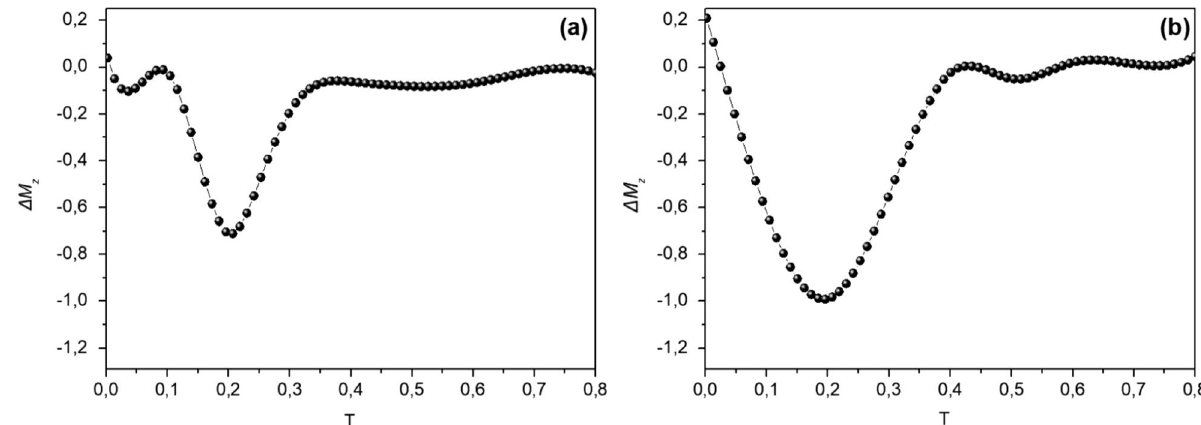
Figure 5. Difference ΔΜ between ZFC reference and ZFC memory curves for: ( a ) the system in absence of dipolar interactions (g = 0); ( b ) the system in the absence of exchange interparticle interactions (j inter = 0).